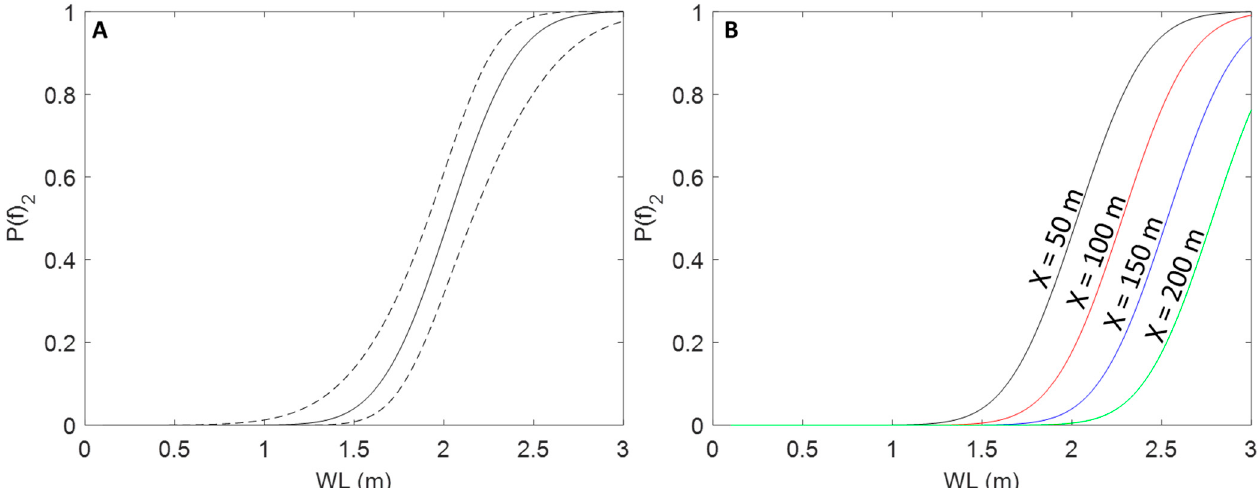
Figure 4. Probability P(f) 2 of roadway transect flooding as a function of water level WL at the marina tide gauge (NAVD88) for ( A ) buffer distance X = 50 m (black curve) and 95% confidence intervals (black dashed curves); ( B ) buffer distances X = 50 m, 100 m, 150 m, and 200 m (black, red, blue, and green curves, respectively).